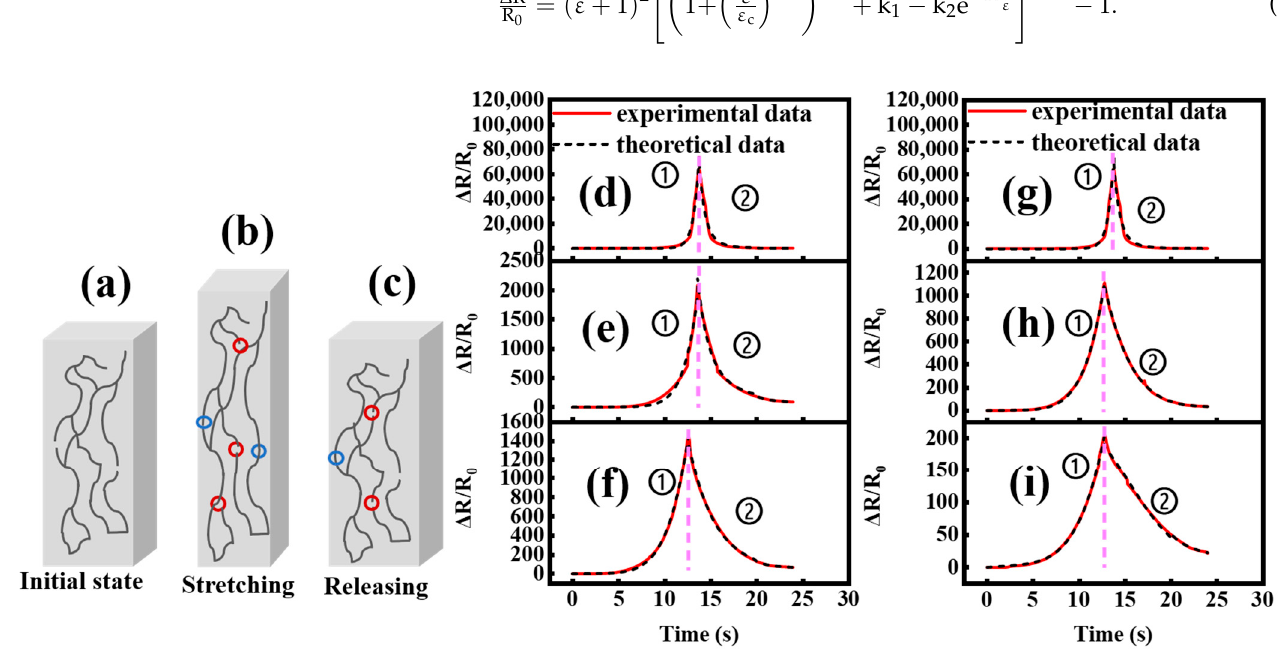
Figure 7. ( a – c ) MWCNT conductive network changes in the whole cycle, where disconnection is represented by the red ellipse and recombination is shown with the blue ellipse. The MWCNT/VMQ- DCP at MWCNT content of ( d ) 4 wt%, ( e ) 5 wt%, and ( f ) 6 wt%, and the MWCNT/VMQ-DBPMH at MWCNT content of ( g ) 4 wt%, ( h ) 5 wt%, and ( i ) 6 wt%, with 1 (cid:13) denoting the tensile stage and 2 (cid:13) denoting unloading (theoretical predictions are shown in black and experimental results are shown in